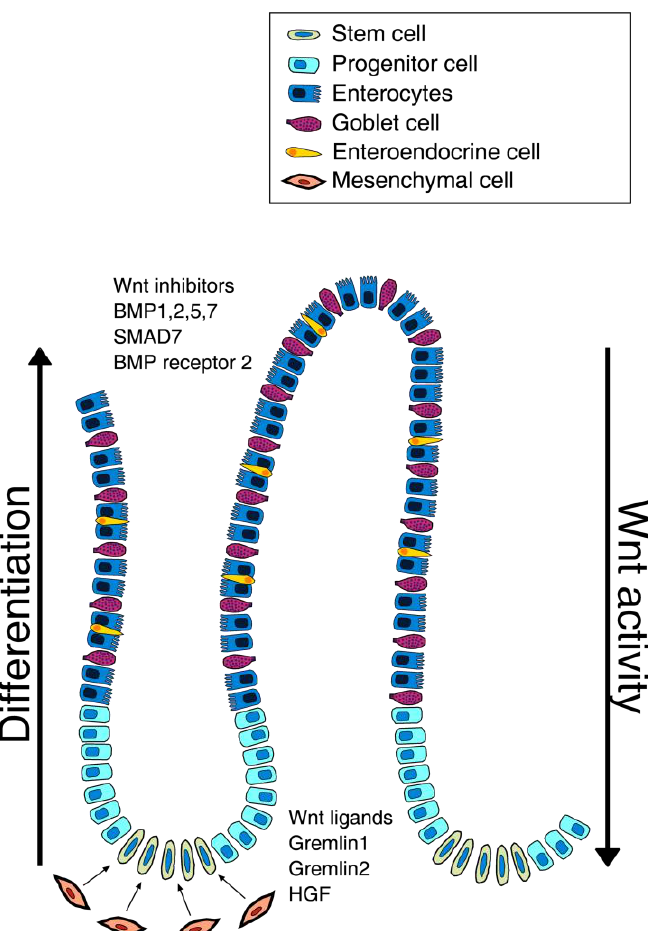
Figure 1. Graphic representation of a colon